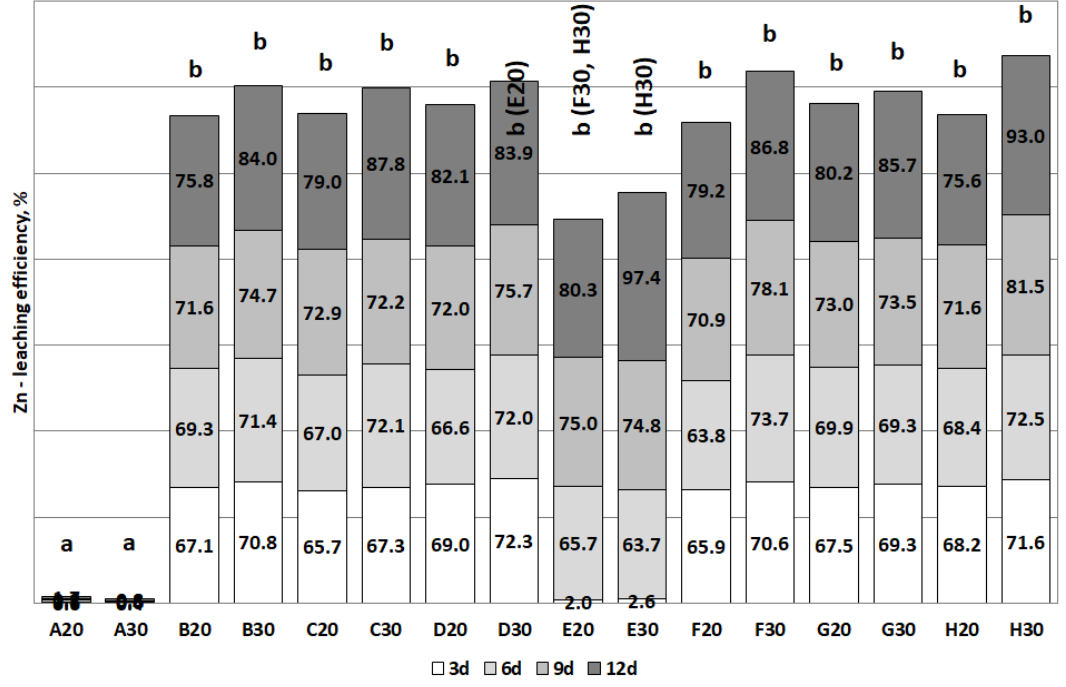
Figure 16. Bioleaching efficiency of Zn during the experiment (Statistical groups a and b ).